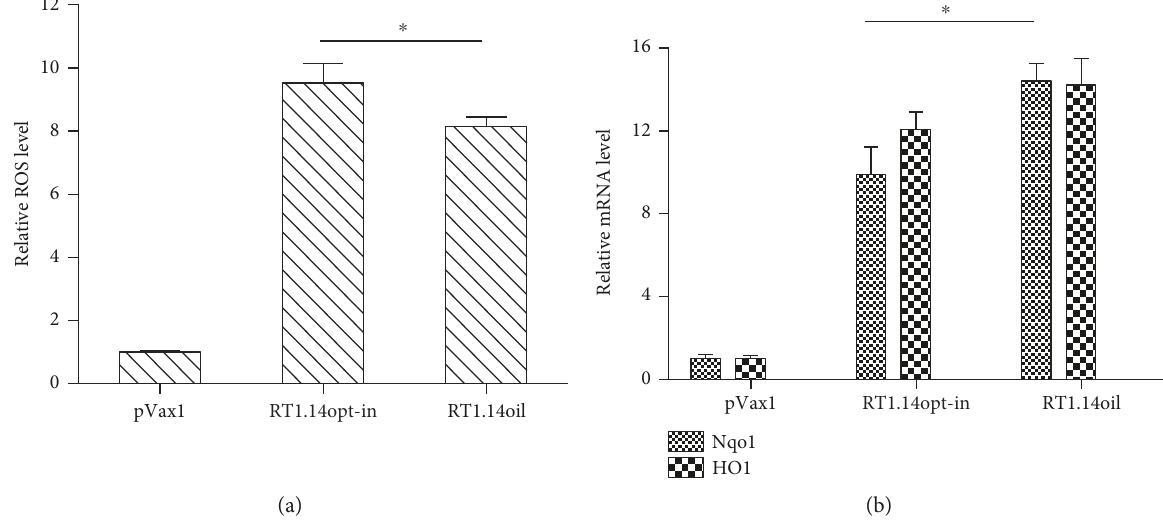
Figure 6: Induction of oxidative stress and oxidative stress response in cells expressing multidrug-resistant inactivated reverse transcriptase RT1.14opt-in and its derivative RT1.14oil carrying a signal peptide. Induction of the oxidative stress was detected as the production of ROS (a) and increase in the levels of mRNA of the phase II detoxi fi cation enzymes Nqo1 and HO1 (b). Levels of ROS were normalized to those in HEK293T cells transfected with the empty vector pVax1. Levels of mRNA for Nqo1 and HO-1 were normalized to levels of mRNA for actin and then represented as fold di ff erence to the e ff ect of empty vector pVax1. Data represent the results of two independent experiments, each done in triplicate, +SD. Results are compared using F test (Statistica AXA 10), ∗ p < 0 05